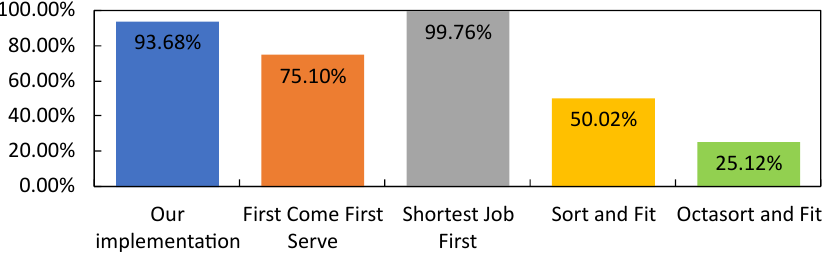
Figure 11. Average accuracy in meeting the computation deadline against previously proposed scheduling algorithms.